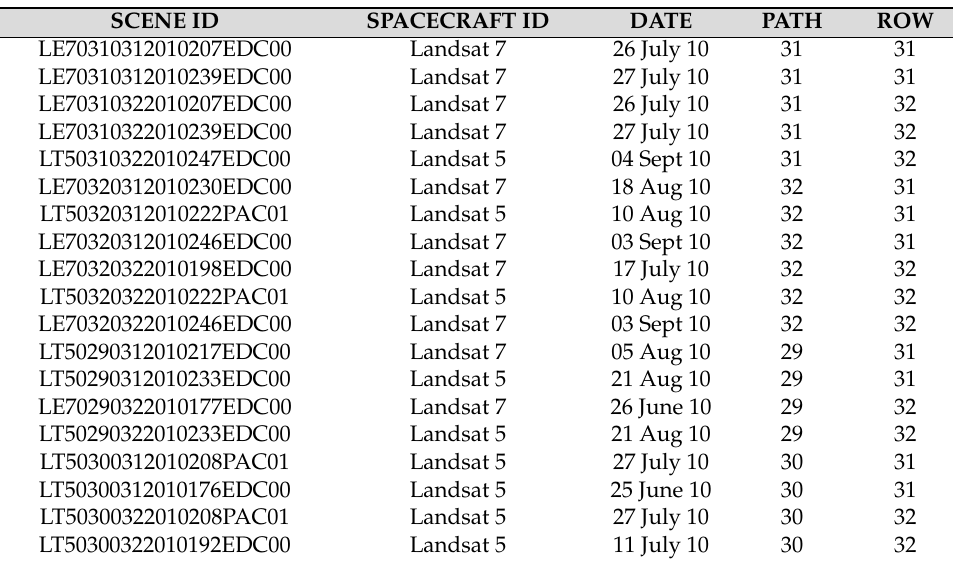
Table A1. Landsat scene identification (ID), acquisition spacecraft and date, and path and row of images used for the